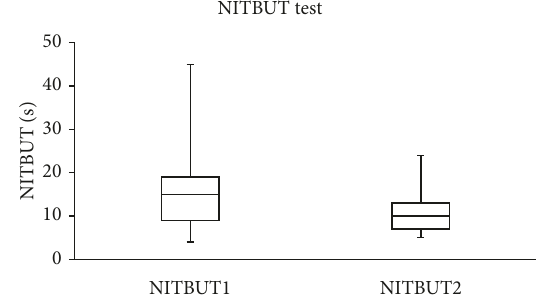
Figure 2: Side-by-side boxplots for the NITBUT scores for the study group before (NITBUT1) and after wearing (NIBUT2) a face mask.